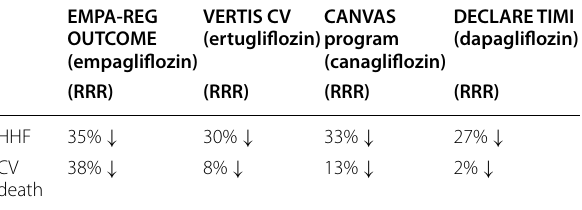
Table1 Reduction in heart failure hospitalisation and CV